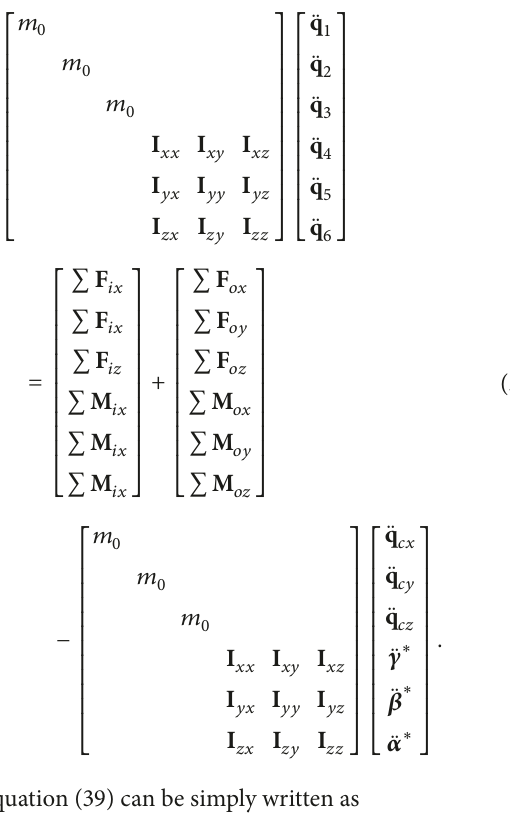
Kutta method are used to solve the dynamic model. The calculation flow of dynamic model is shown in Figure 7. The detailed process is expressed as